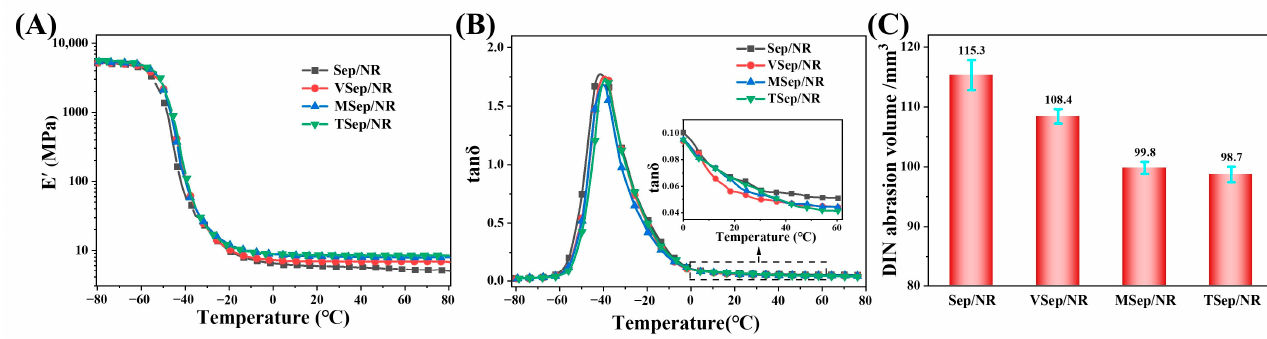
Figure 11. ( A ) Temperature dependence of the E’, ( B ) tan δ , and ( C ) DIN abrasion volume of sepio- lite/NR composites. sepiolite/NR